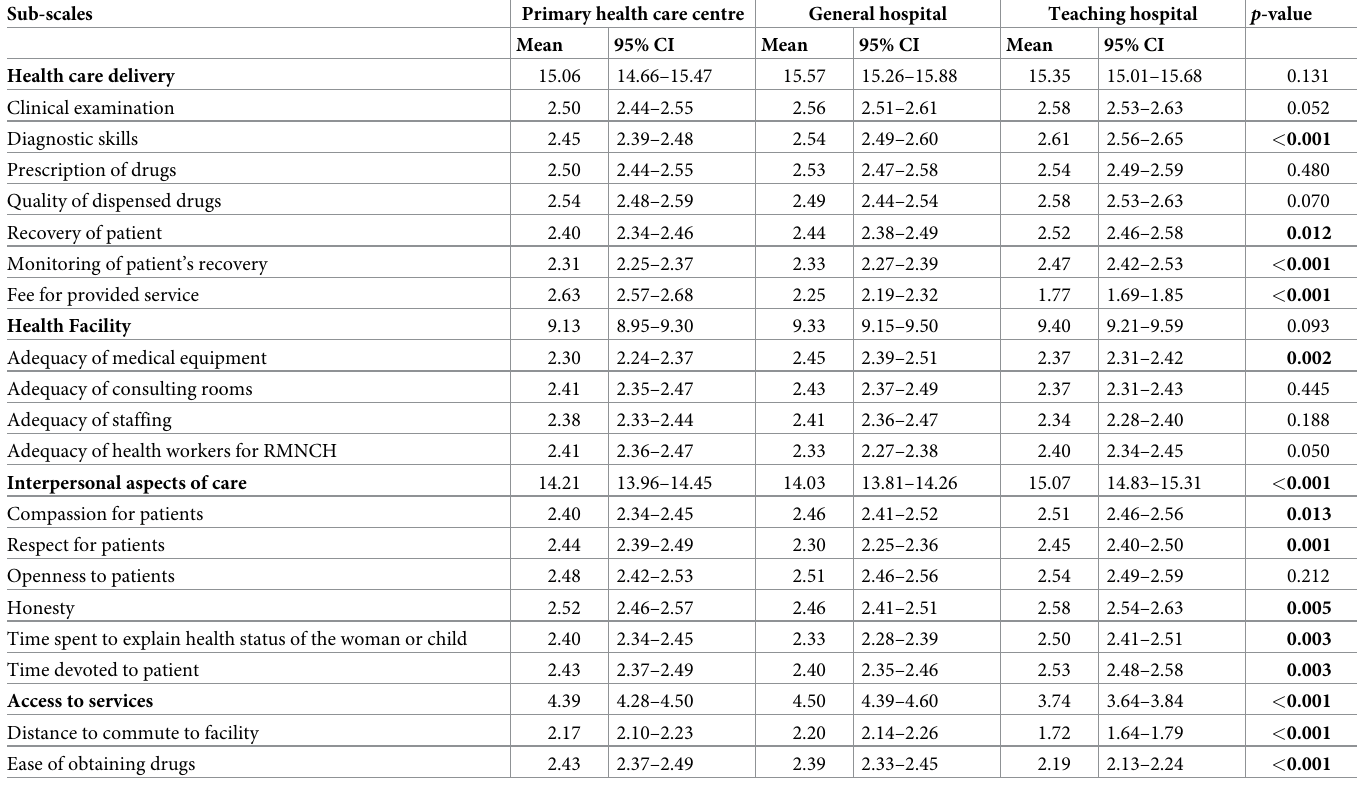
Table 2. Clients’ satisfaction with RMNCH services per facility type during the COVID-19 outbreak in Lagos